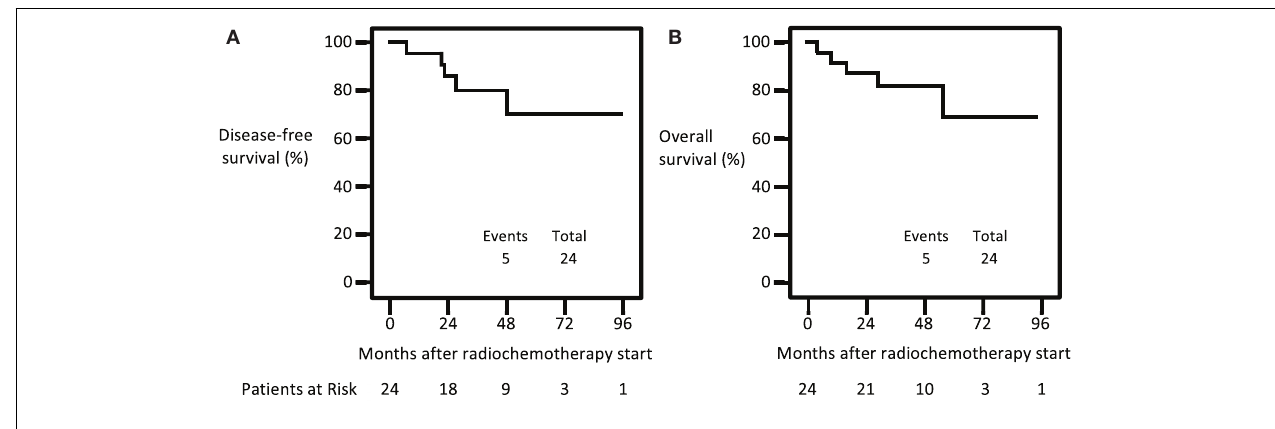
FIGURE 2 | Kaplan–Meier survival curves for disease-free survival (A) and overall survival (B)